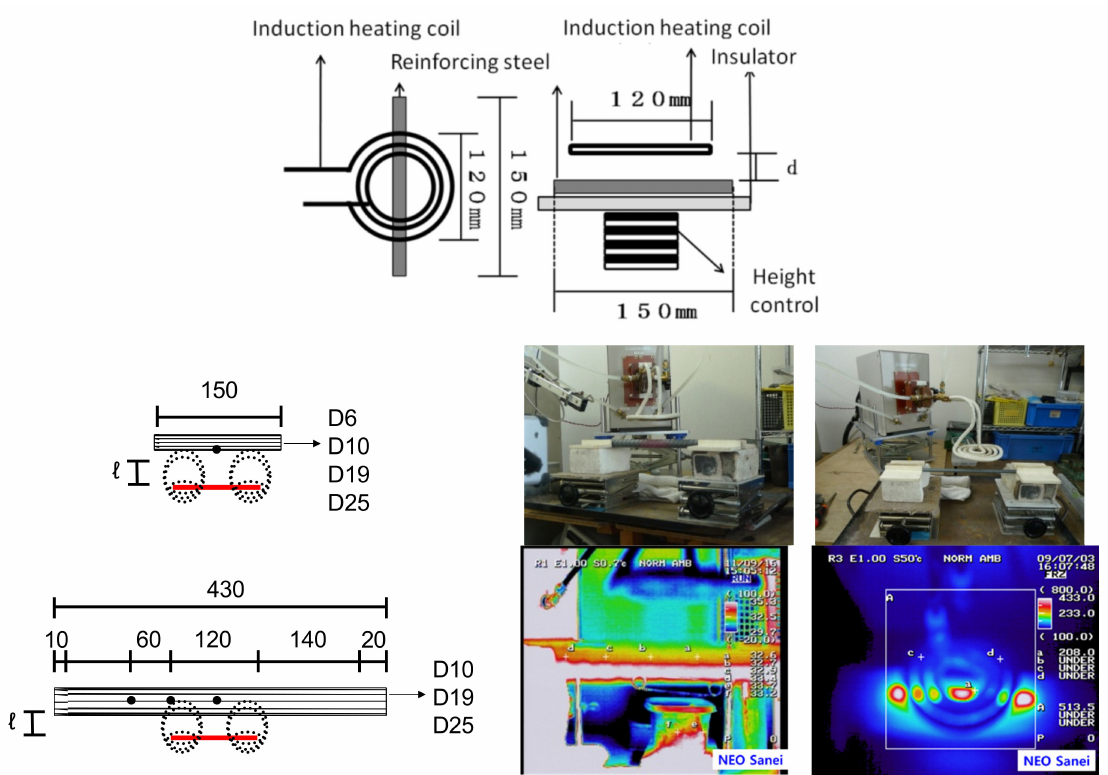
Figure 6. Heating experiment for single reinforcing bar.